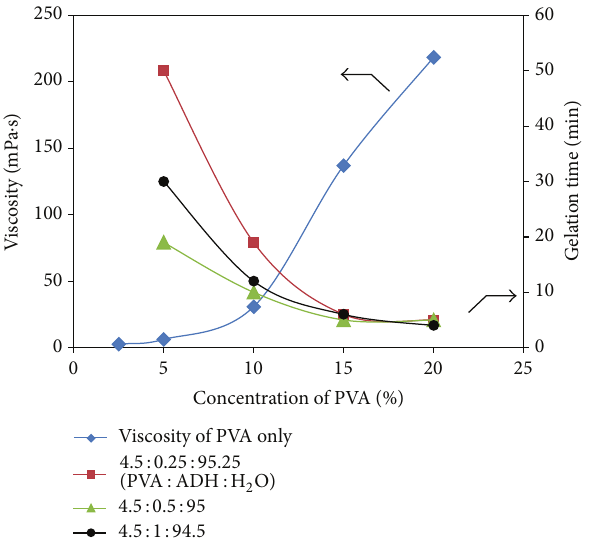
Figure 8: Viscosity of PVA solutions and gelation time of the PVA hydrogel at three concentrations (PVA: ADH : H 2 O).